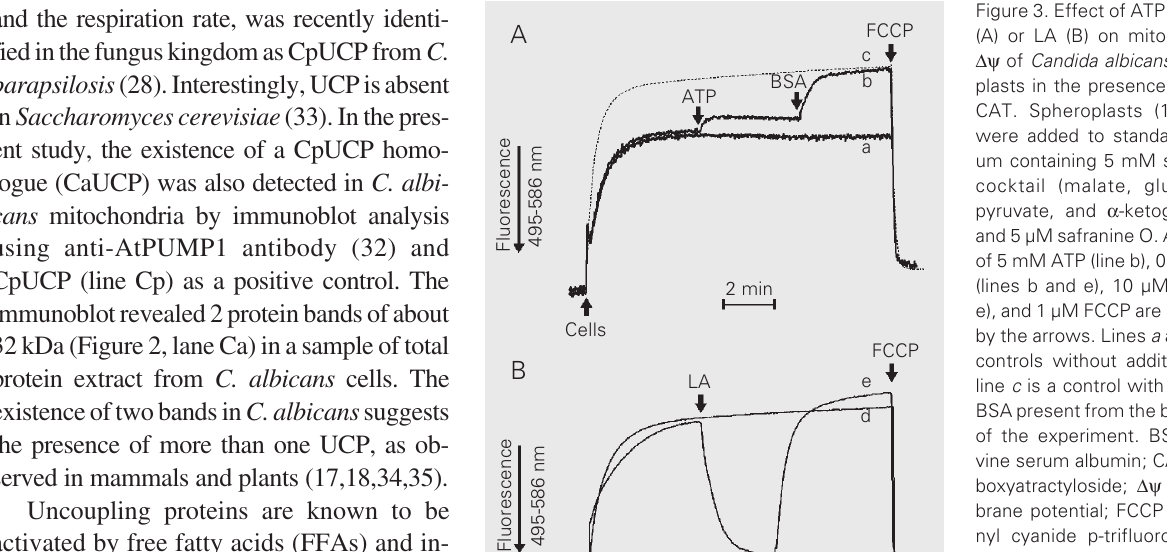
Figure 3. Effect of ATP and BSA (A) or LA (B) on mitochondrial ∆ψ of Candida albicans sphero- plasts in the presence of 1 µM CAT. Spheroplasts (1 mg/ml) were added to standard medi- um containing 5 mM substrate cocktail (malate, glutamate, pyruvate, and α -ketoglutarate) and 5 µM safranine O. Additions of 5 mM ATP (line b), 0.5% BSA (lines b and e), 10 µM LA (line e), and 1 µM FCCP are indicated by the arrows. Lines a and d are controls without additions and line c is a control with ATP and BSA present from the beginning of the experiment. BSA = bo- vine serum albumin; CAT = car- boxyatractyloside; ∆ψ = mem- brane potential; FCCP = carbo- nyl cyanide p-trifluoromethox- yphenylhydrazone; LA = linoleic